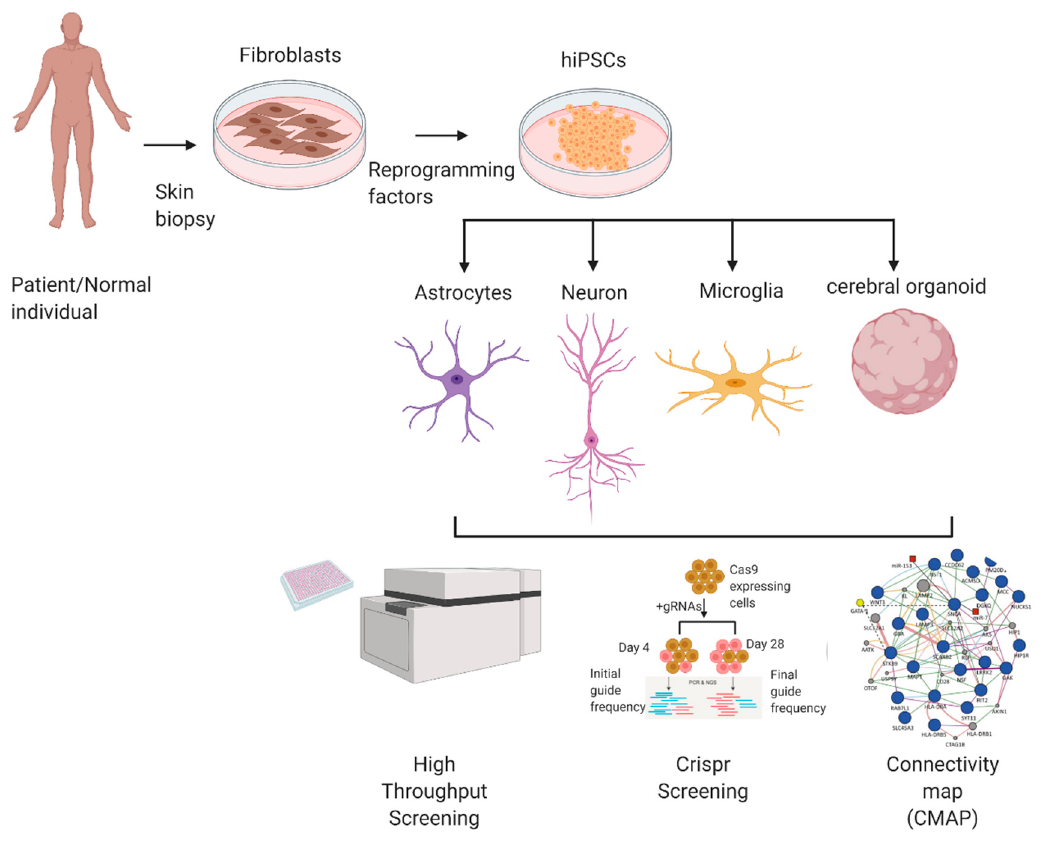
Figure 1. hiPSC-derived brain models in drug discovery. Diagram illustrating the use of hiPSCs to generate various brain cells (neurons, astrocytes, microglia) and 3D cerebral organoids, which can be used to model different neurological disorders. Myelin-forming oligodendrocytes can also be modeled with hiPSC differentiation protocols but are not shown here. These hiPSCs can be used for drug discovery using various methods, e.g., high-throughput screening, CRISPR screening, and Connectivity Map score for transcriptome correction.